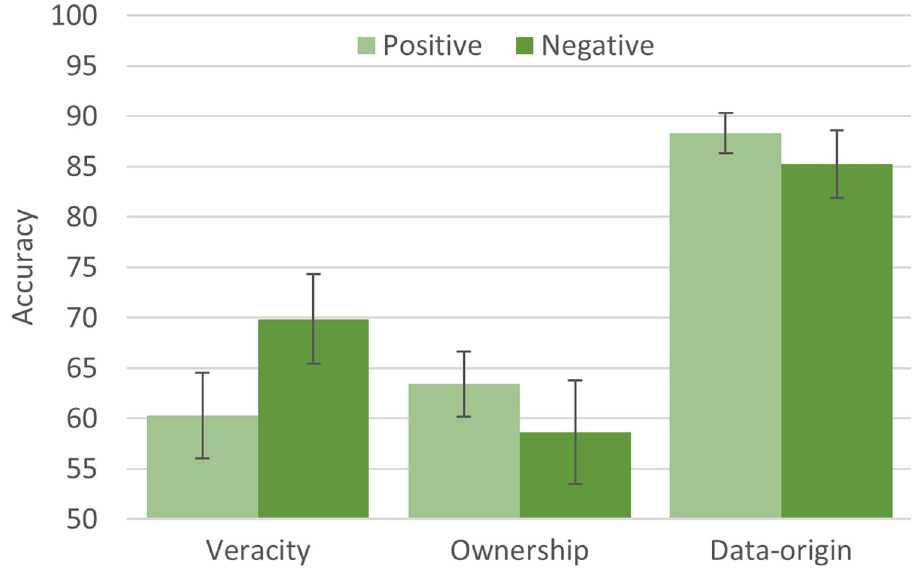
Fig 2. Classification accuracies (with 99% CI) of analyses 1 ( veracity ), 2 ( ownership ), and 3 ( data-origin ); accuracy ranges from 50% (chance level) to 100%.